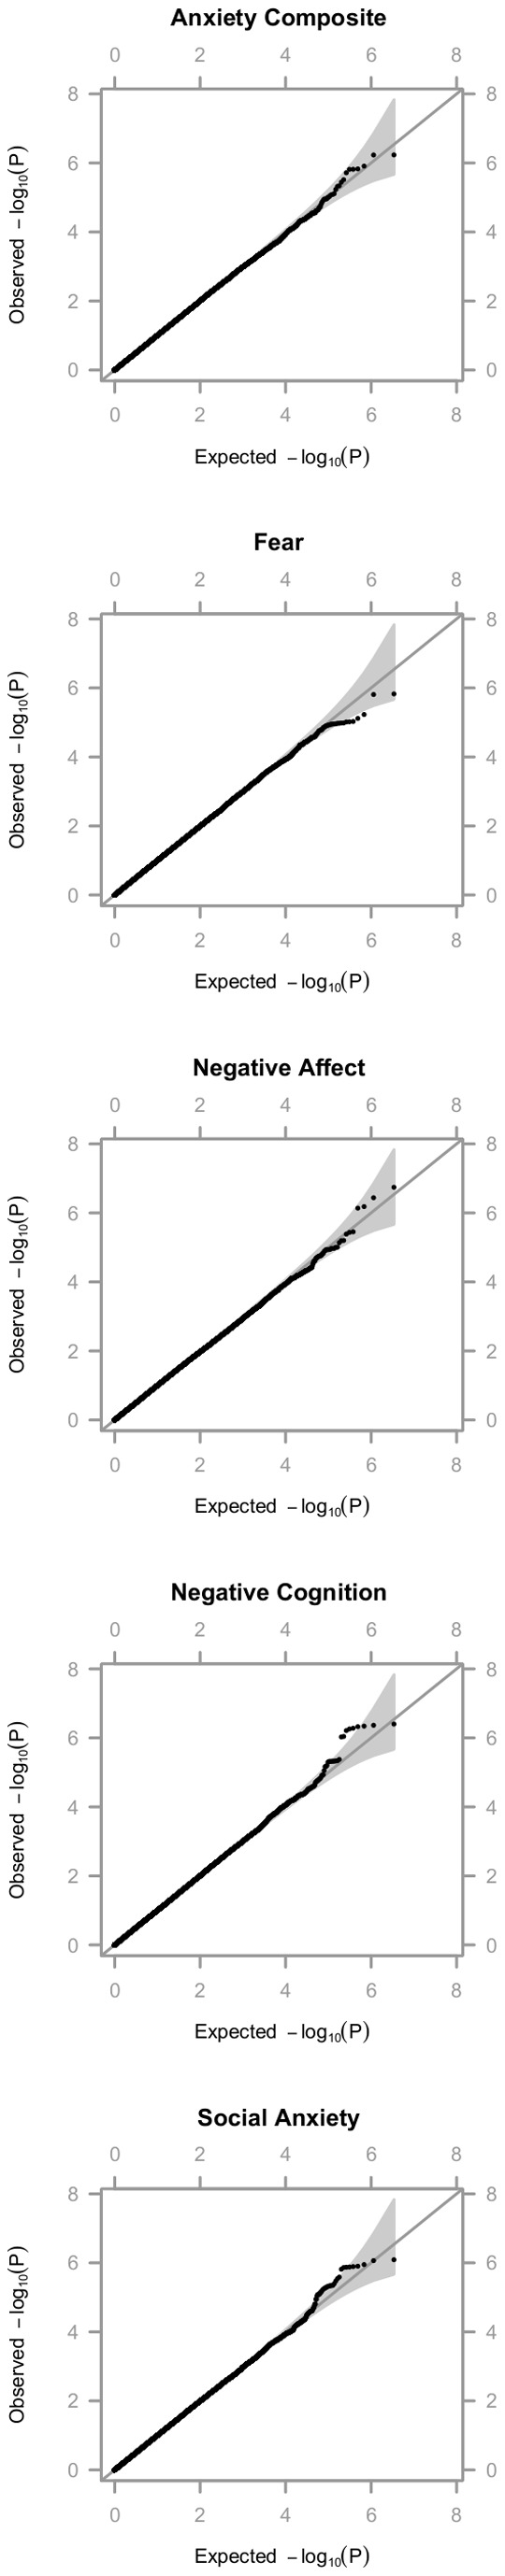
Log quantile-quantile (Q–Q) p-value plots for 1,724,317 single-SNP test of association of four anxiety-related traits and the anxiety composite at age 7.Footnote: Expected (X-axis) versus observed (Y-axis) p-values are plotted on the negative log scale to highlight the strongest associations. The diagonal line represents the null hypothesis and the grey polygons represent the 95% confidence interval (CI) of the null range. Significant association would be indicated by departure of the p-value (black dot) beyond the 95% CI of the null range.